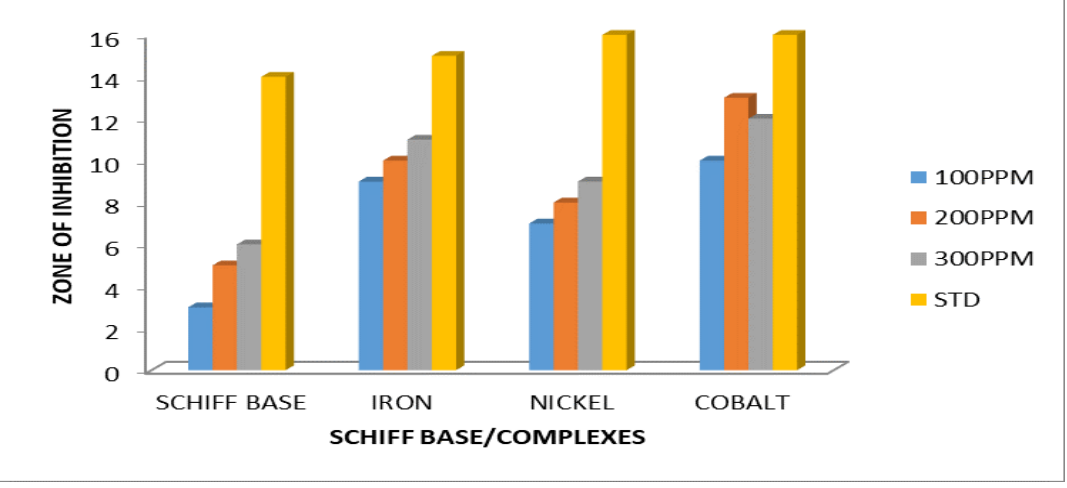
Figure 3. Sensitivity test for antibacterial activity of Schiff base and its metal (II) complexes against clinical isolate ( Streptococcus pneumoniae ) using well diffusion method.